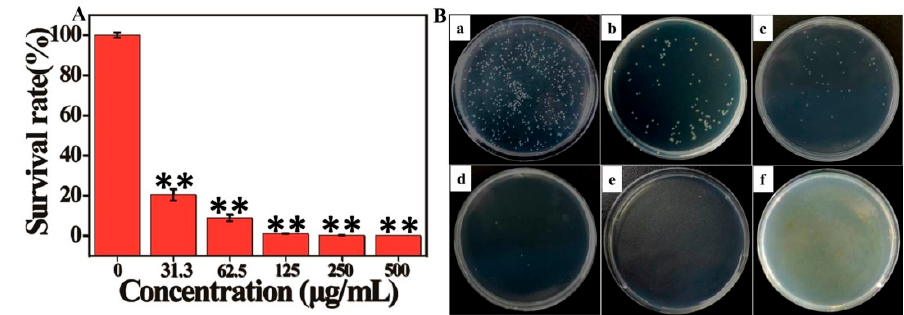
Figure 3. In vitro antibacterial activity test. ( A ) Cell survival rate of Salmonella cells treated or untreated with MnO 2 nanosheets (31.5–500 µ g / mL). ( B ) Photographs of the agar plates of Salmonella treated or untreated with MnO 2 nanosheets, with a–f corresponding to the concentrations of MnO 2 nanosheets in Figure 3A (a–f: 0, 31.3, 62.5, 125, 250, 500 µ g / mL). ** p <